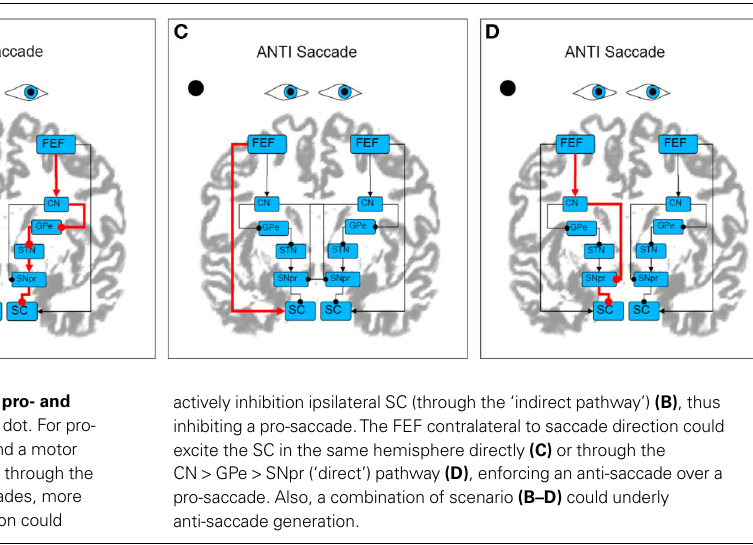
actively inhibition ipsilateral SC (through the ‘indirect pathway’) (B) , thus inhibiting a pro-saccade. The FEF contralateral to saccade direction could excite the SC in the same hemisphere directly (C) or through the CN > GPe > SNpr (‘direct’) pathway (D) , enforcing an anti-saccade over